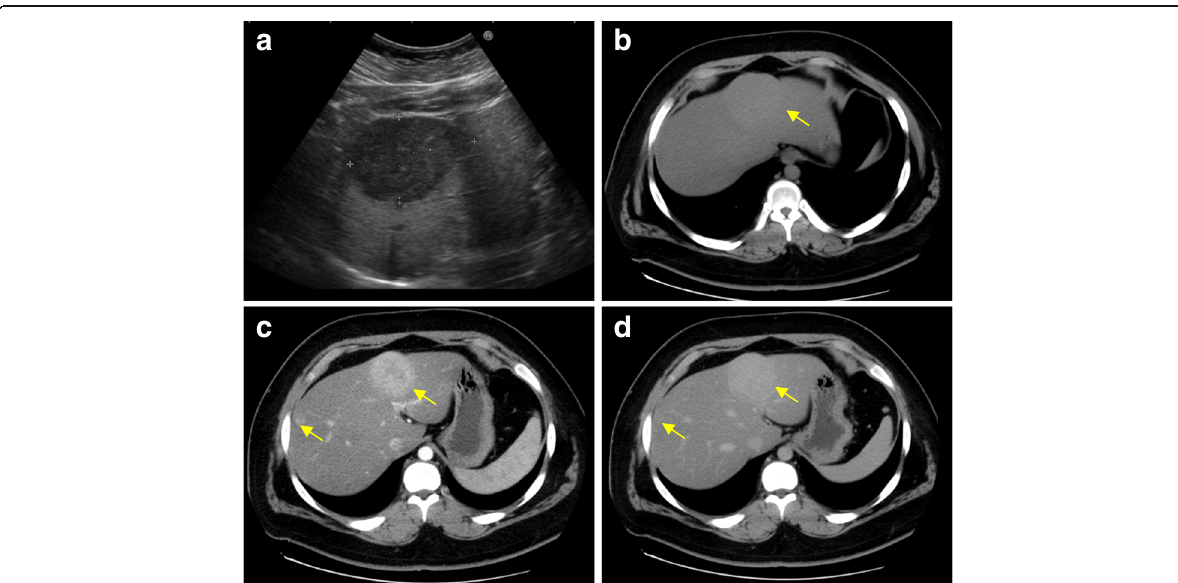
Fig. 1 Preoperative ultrasonography and computed tomography images showing the presence of tumors. a Abdominal ultrasonography image showing a hypoechoic tumor approximately 7 cm in diameter protruding forward on the surface of the left lobe. b Plain computed tomography image showing an isodense tumor in the left lobe. c Contrast-enhanced computed tomography (CECT) image showing two tumors in segments 3/4 and 8 that were enhanced in the arterial phase. d CECT showing the two tumors with prolonged enhancement in the late phase